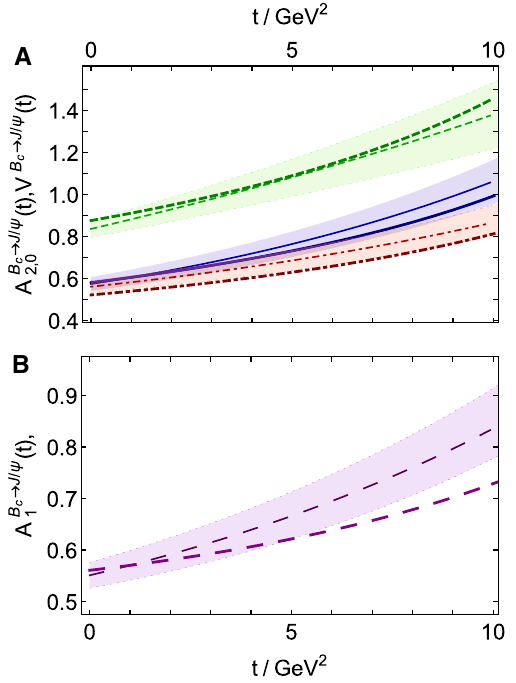
Fig. 6 A SCI predictions for precursors to the Isgur–Wise function, Fig. 7 SCI predictions for B + c → J /ψ semileptonic transition form (w)/ h ( 1 ) Eq.(20), obtained from B 0 → D ∗ , D transitions: h A A 2 2 factors. A A 2 ( t ) – dot-dashed red curve; A 0 ( t ) – solid blue; V ( t ) – (w)/ h ( 1 ) – long-dashed purple; – dot-dashed red curve; h A A 1 1 dashed green. B A 1 ( t ) – long-dashed purple curve. In both panels, the (w)/ h ( 1 ) – solid blue; h (w)/ h ( 0 ) – dashed green; h A A 0 V V 0 thinner, like-texture and -colour curves within shaded bands are the ξ (w)/ξ ( 1 ) – mid-dashed, thin black curve [6, Sec.7]. Empirical f + f + CSM predictions from Ref. [49] result [84, Eqs.(177), (181)] – thinner tomato-coloured curve within like-coloured bands. B SCI predictions as in Panel A, but obtained using B s → D ∗ s , D s transitions. Both panels: gold stars, Isgur–Wise function inferred from measurement of B → D [90, Belle] prediction for R ( J /ψ) and the measurement in Ref. [72, curve, drawn in Fig.6A, agrees well with the SCI predic- ˆ (w) ≈ ˆ h (w) . h A tions for A 2 1